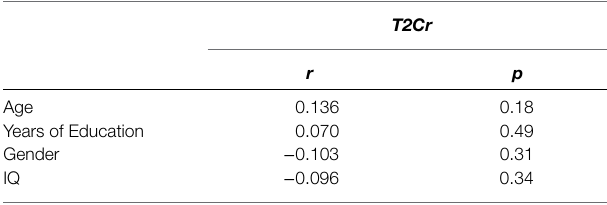
TABLE 2 | Bivariate correlation analysis (Spearman’s rho) between Trials to Criterion and Age, Years of Education, Gender and IQ.